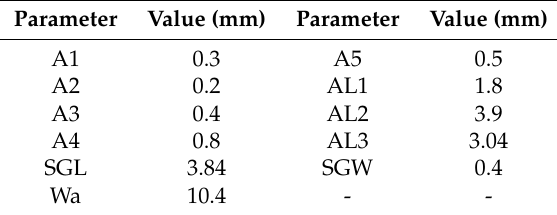
Table 4. Parameters of the antenna array.